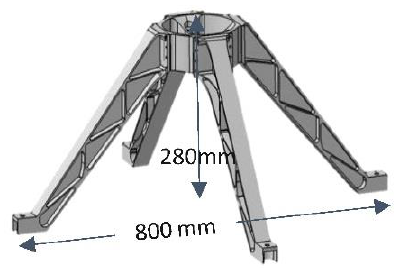
Figure 5. Nominal Lunar Lander engine mount.